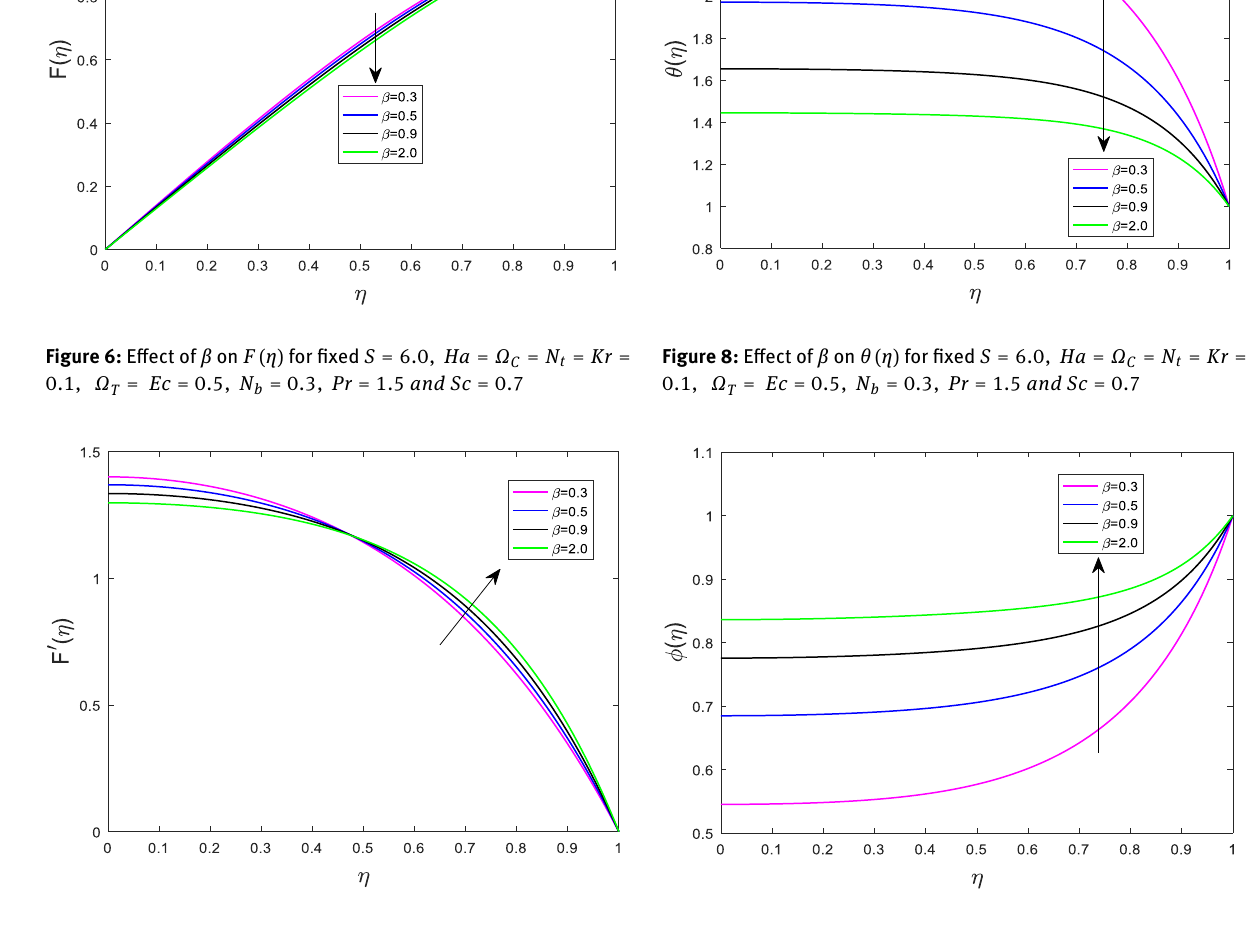
Figure 7: Effect of β on F (cid:48) ( η ) for fixed S = 6.0, Ha = Ω C = N t = Kr = 0.1, Ω = Ec = 0.5, N = 0.3, Pr = 1.5 and Sc = 0.7 b T